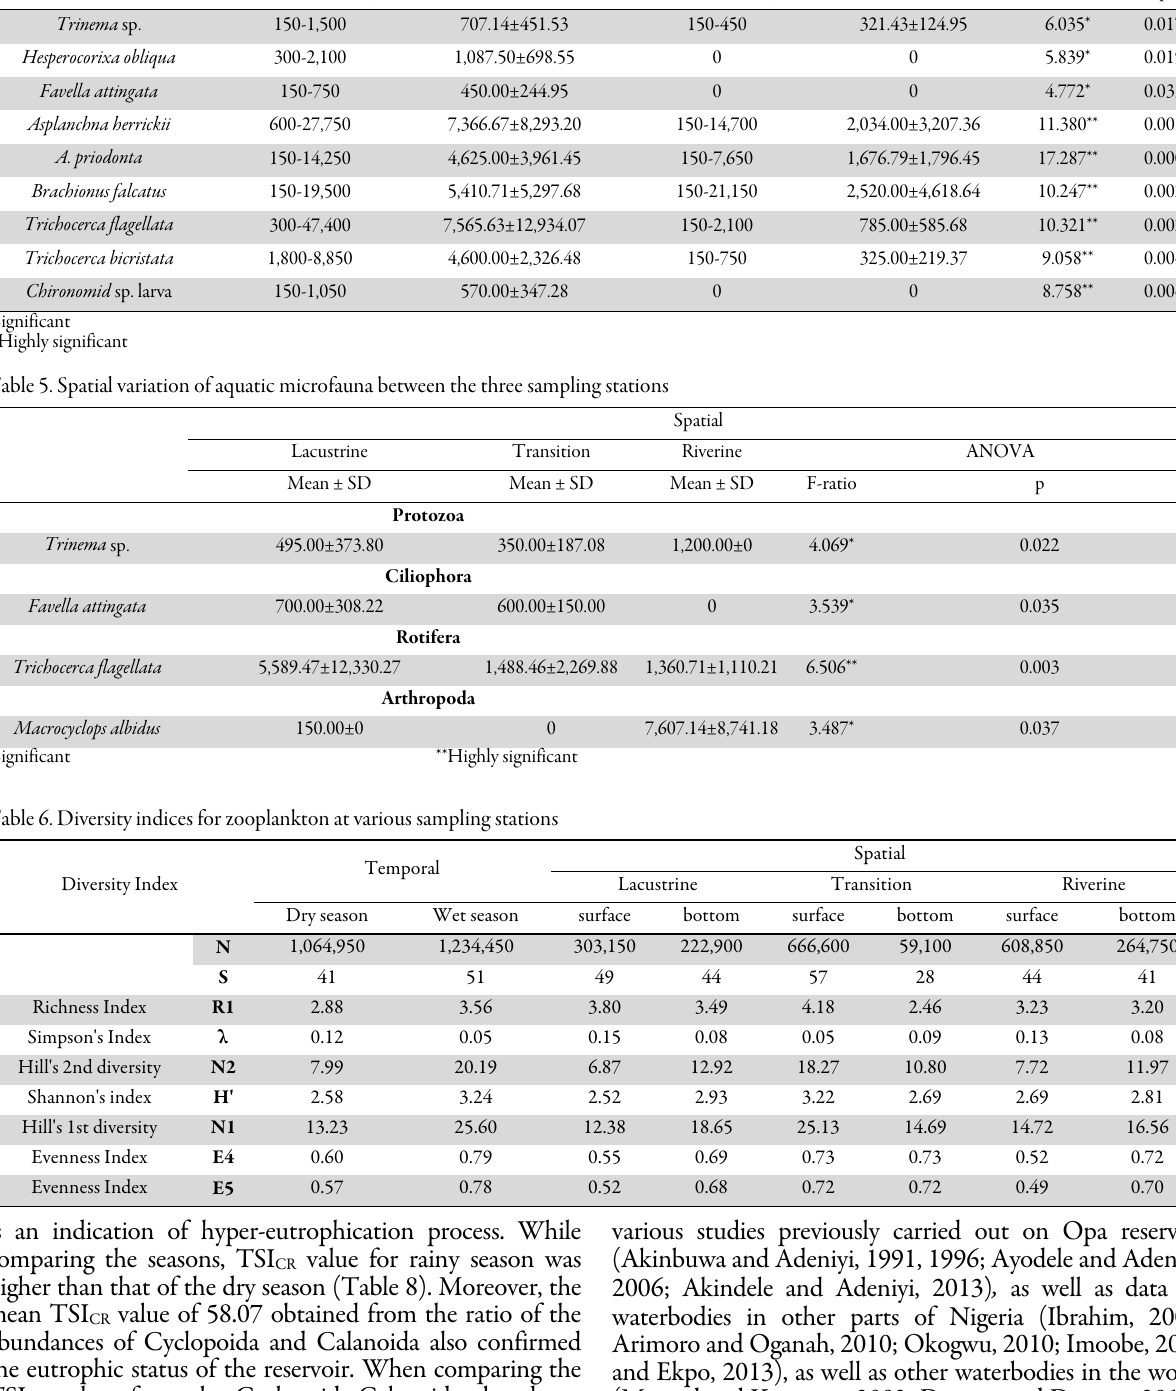
Table 4. Seasonal variation of aquatic microfauna between dry and wet seasons under study Organisms